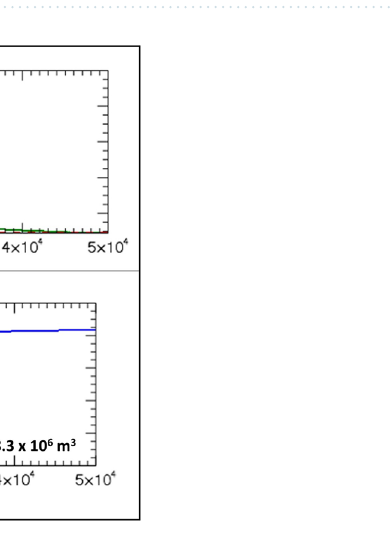
Figure 7. Spatially distributed ( a ) erosion depth (m); ( b ) deposition depths (m) along the flow channel; ( c – e ) post GLOF imageries showing erosion and deposition along the flow channel. Background in panels a and b: ESRI base map overlaid on ALOS PALSAR DEM; (© Esri, Maxar, GeoEye, Earthstar Geographics, CNES/Airbus DS, USDA, USGS, AeroGRID, IGN, and the GIS User Community). Background in panels c-e: Planet Scope imageries (©Planet Scope; URL: https:// www. planet. com). All maps were created using ArcMap 10.8 software (© ESRI, URL: ).